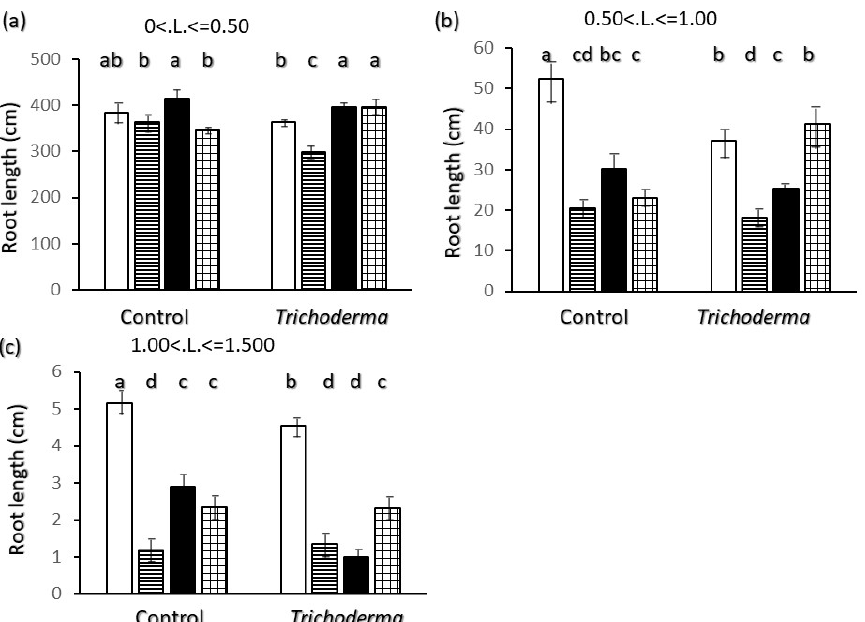
Figure 4. Interaction of wheat variety x Trichoderma harzianum T-22 inoculation on root length values by diameter class: ( a ) diameter class < 0.5 mm; ( b ) diameter class 0.5 < d < 1 mm; ( c ) diameter class 1 < d < 1.55 mm. Color code of bars: white = Ciclope; horizontal stripes = Creso; black = Saragolle; grid = Simeto. Vertical segments on each bar indicate standard deviation n = 3. Different letters on each bar designate significantly different values for p < 0.05 at the Tukey’s post hoc mean separation test.